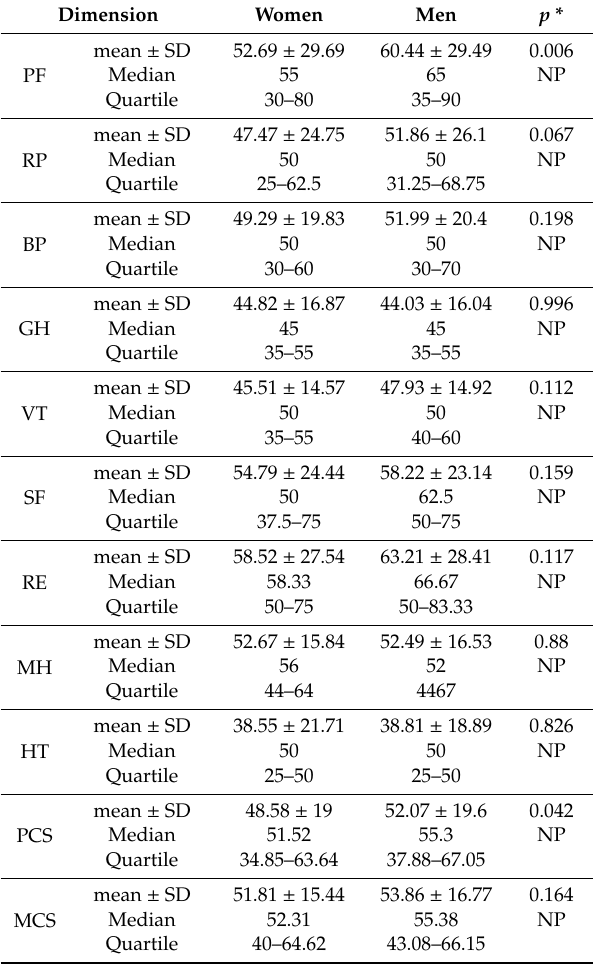
Table 4. Quality of life in individual dimensions versus gender of